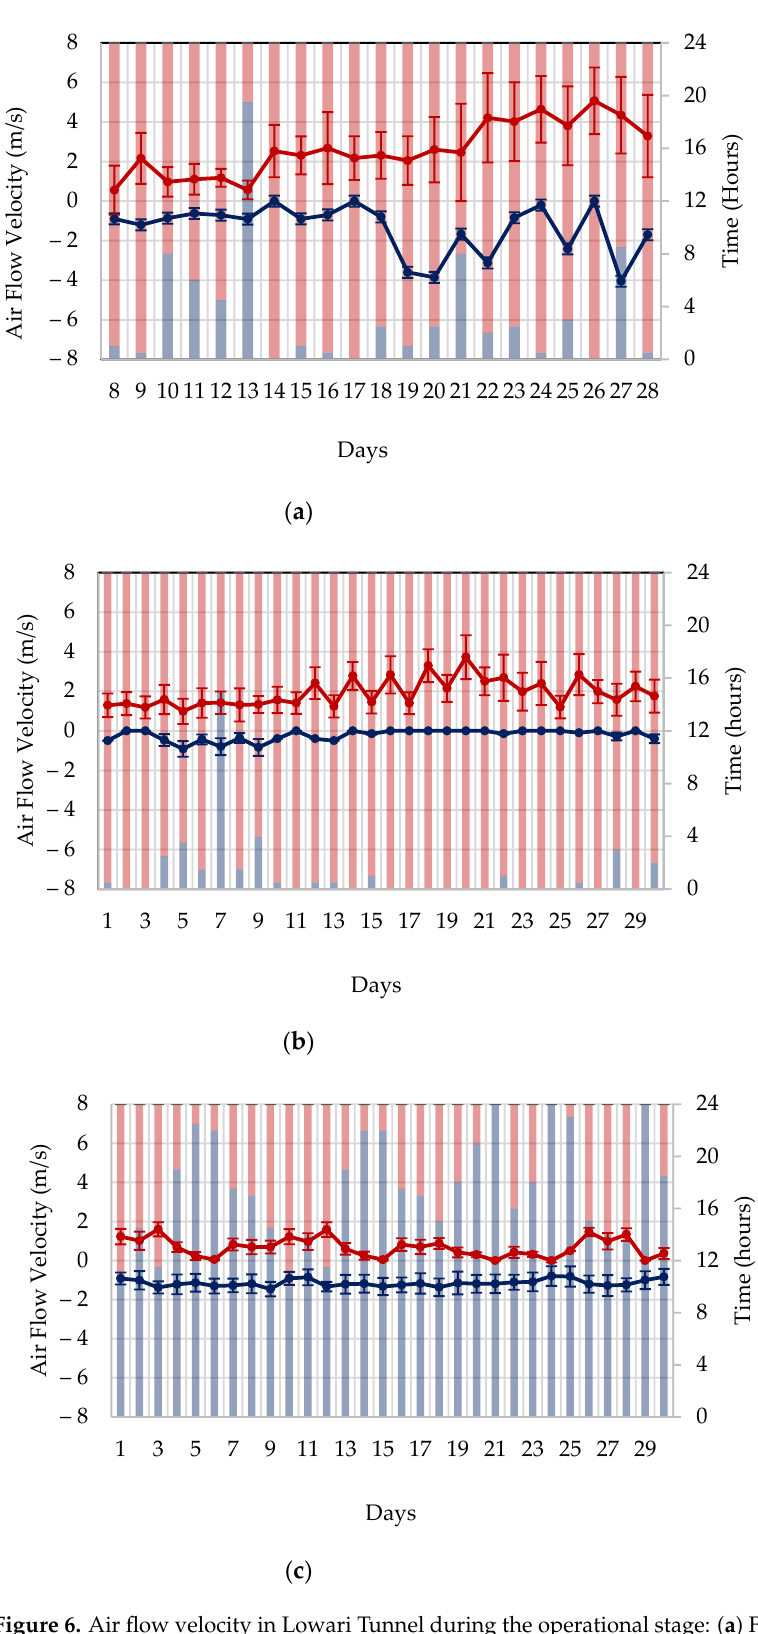
Figure 6. Air flow velocity in Lowari Tunnel during the operational stage: ( a ) February 2018; ( b ) June 2017; ( c ) September 2016. The red color shows the wind direction from south to north and the blue color from north to south.